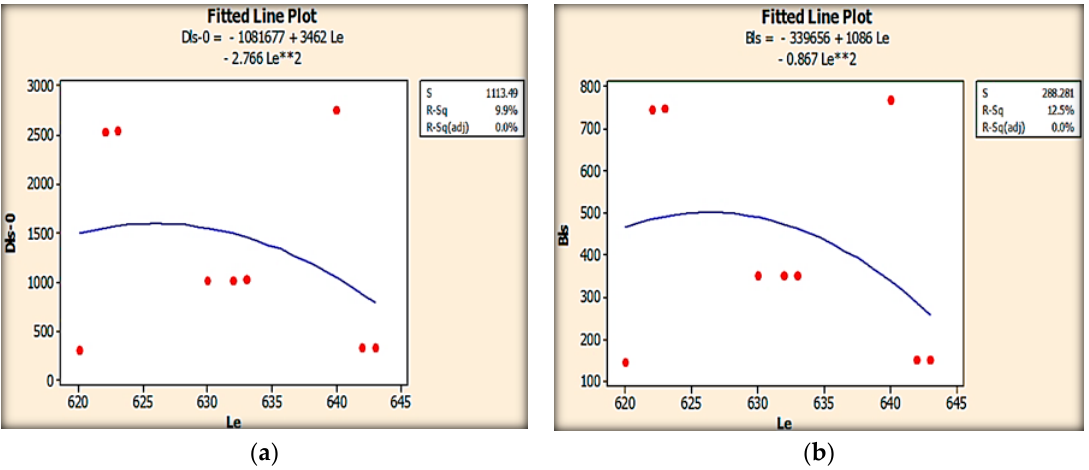
Figure 10. Variation of ( a ) deflection and ( b ) bending for total leaf span.